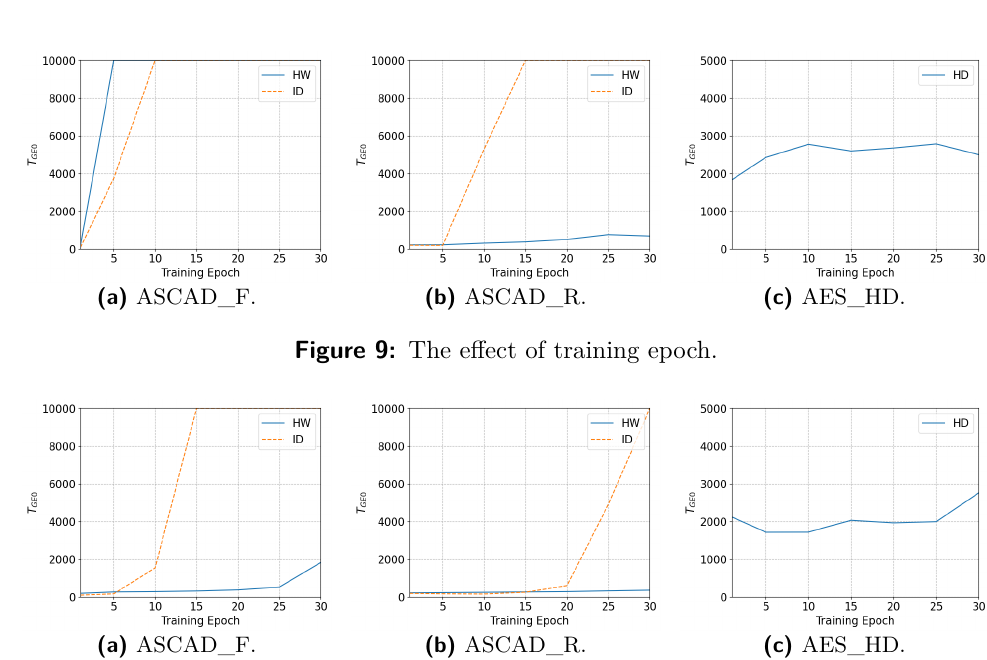
Figure 10: The effect of training epoch with the increased pooling size and